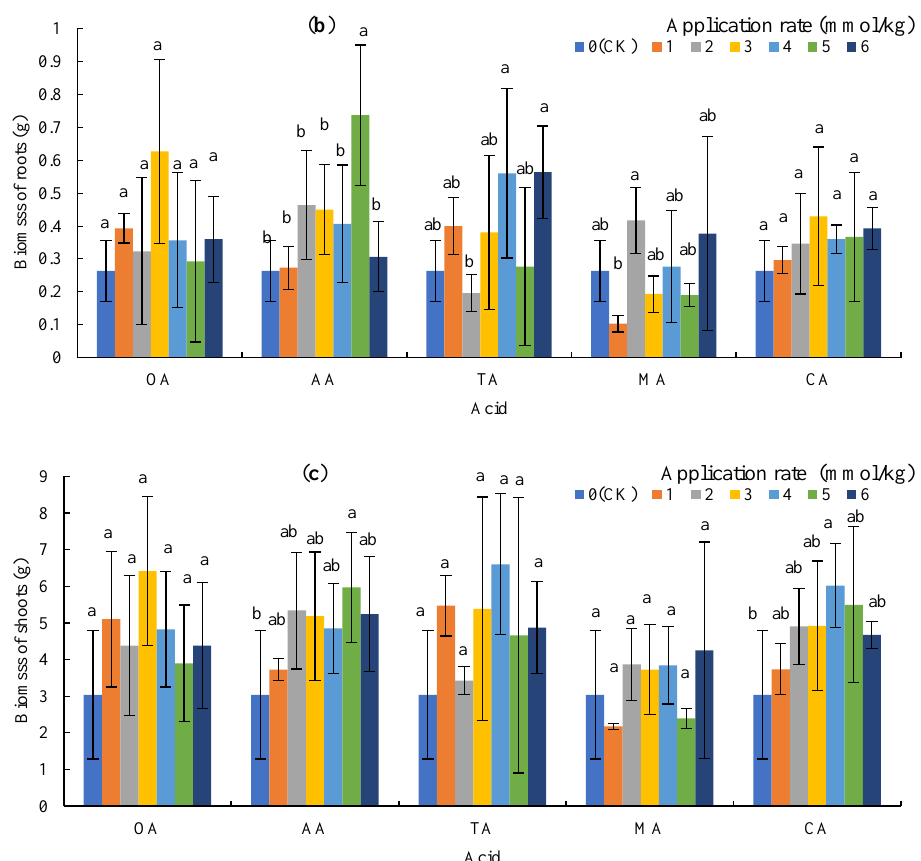
Figure 1. Plant height and biomass under low molecular weight organic acid (LMWOA) treatments and the control (CK). ( a ) Plant height; ( b ) biomass of the roots; ( c ) biomass of the shoots. Different lowercase letters show significant differences for p < 0.05.